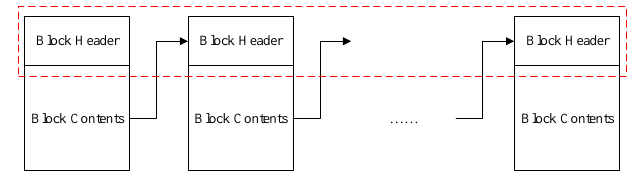
Figure 1. In the SVP scheme, a user stores the headers of the blocks, rather than the blocks themselves. A header contains the relevant meta data (e.g., the root of the Merkle tree whose leaves are the transactions contained in a block). This allows a user to verify whether a given block is valid or